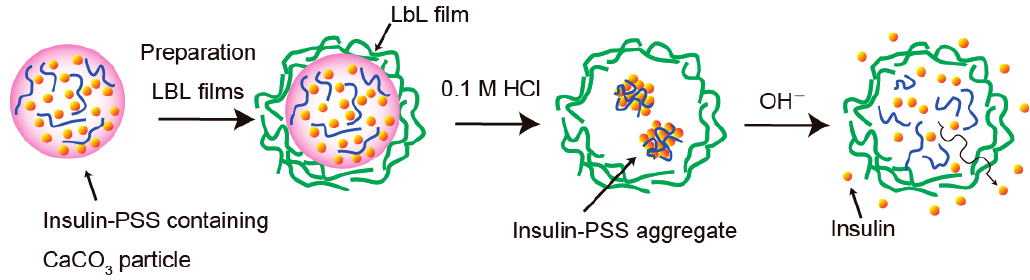
Figure 1. A schematic illustration of the preparation of insulin-containing microcapsule.